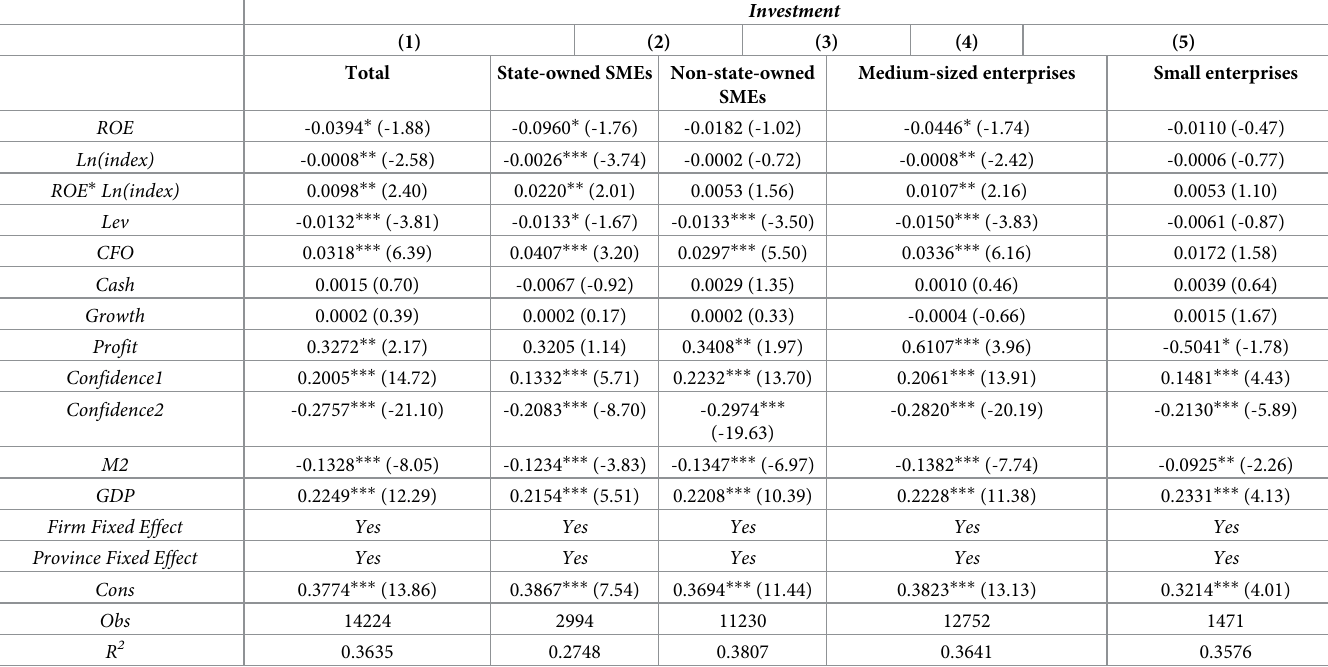
Table 5. Heterogeneous empirical results of SMEs’ fiscal and financial policies and investment